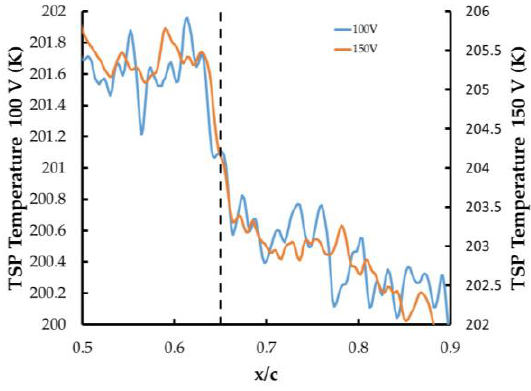
Figure 9. Transition location determined by exciting the CNT layer with 100 V (left axis) and 150 V (right axis).